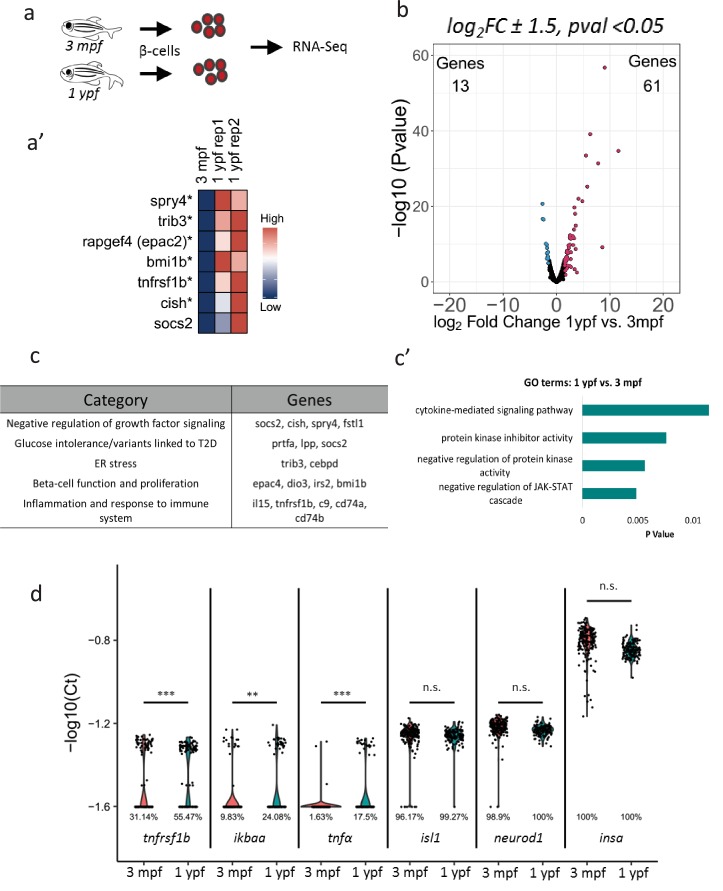
Transcriptome profiling of younger and older beta-cells.(a) Schematic showing isolation and FAC-sorting of beta-cells from Tg(ins:nlsRenilla-mKO2) animals at 3 mpf and 1 ypf followed by high-throughput mRNA-Sequencing. (a’) Heatmap depicting differentially regulated genes among the beta-cells at 1 ypf and 3 mpf involved in beta-cell proliferation, function and inflammation (asterisks denote genes vaildated by single-cell RT-qPCR). (b) Volcano plot representing the distribution of genes that were differentially regulated in beta-cells from 1 ypf and 3 mpf (1.5-log2fold change, p<0.05). (c) The biological categories of enriched genes in beta-cells at one ypf (1.5-log2fold change, p<0.05) based on literature survey. (c’) Unbiased gene-ontology analysis using DAVID of genes enriched in beta-cells at 1 ypf (p<0.05). (d) Gene expression analysis was carried out using single-cell RT-qPCR. Violin plots denote expression distribution of the candidate genes. The Y-axis shows -log10(Ct) values of transcript levels in single beta-cells. The X-axis shows gene names and the respective developmental stages. The percentage values under each violin plot denote the proportion of beta-cells with detectable transcript levels. The cycle threshold for detectable gene expression was set as Ct = 40. The value −1.6 (-log10(40)) on the Y-axis represents undetectable expression as measured by single-cell RT-qPCR (see Materials and methods). Each dot represents one beta-cell. Significance testing for differences in proportion of cells with detectable gene expression at each stage was performed using Pearson’s Chi-Square test (**p<0.01, ***p<0.001).